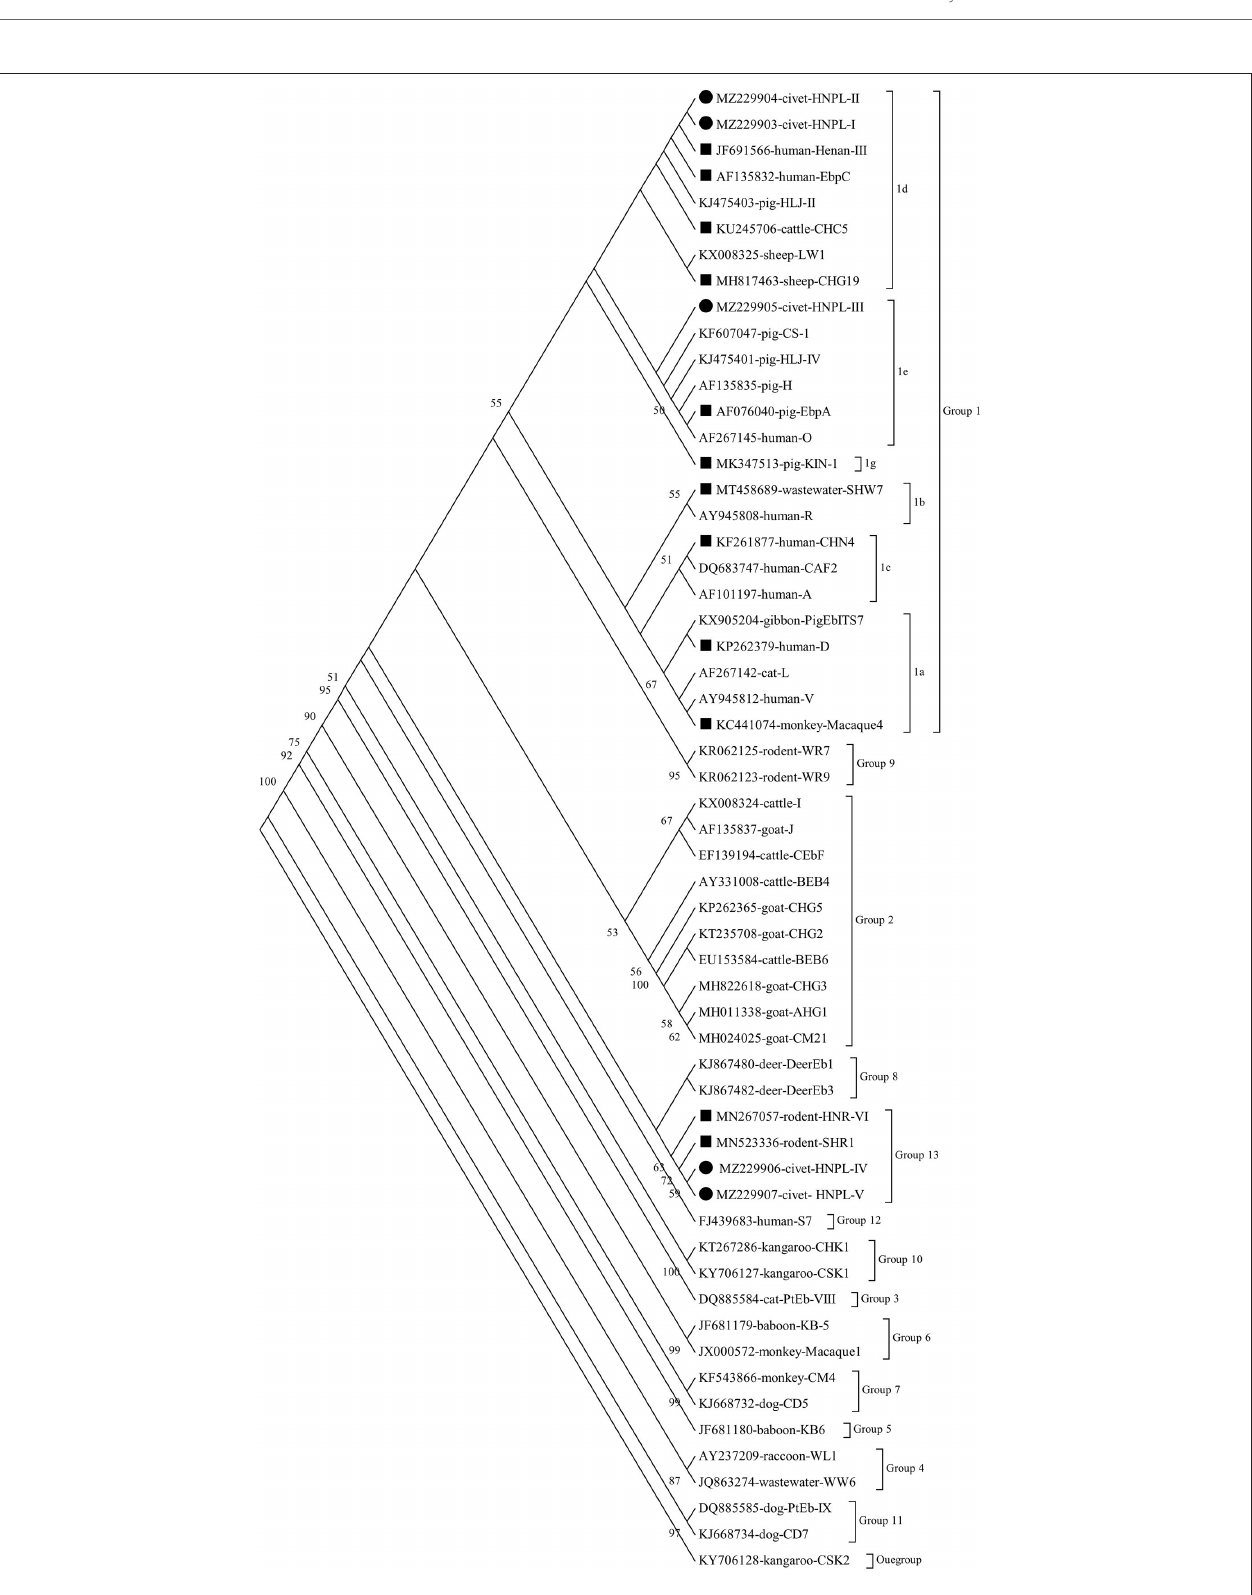
Frontiers in Veterinary Science |